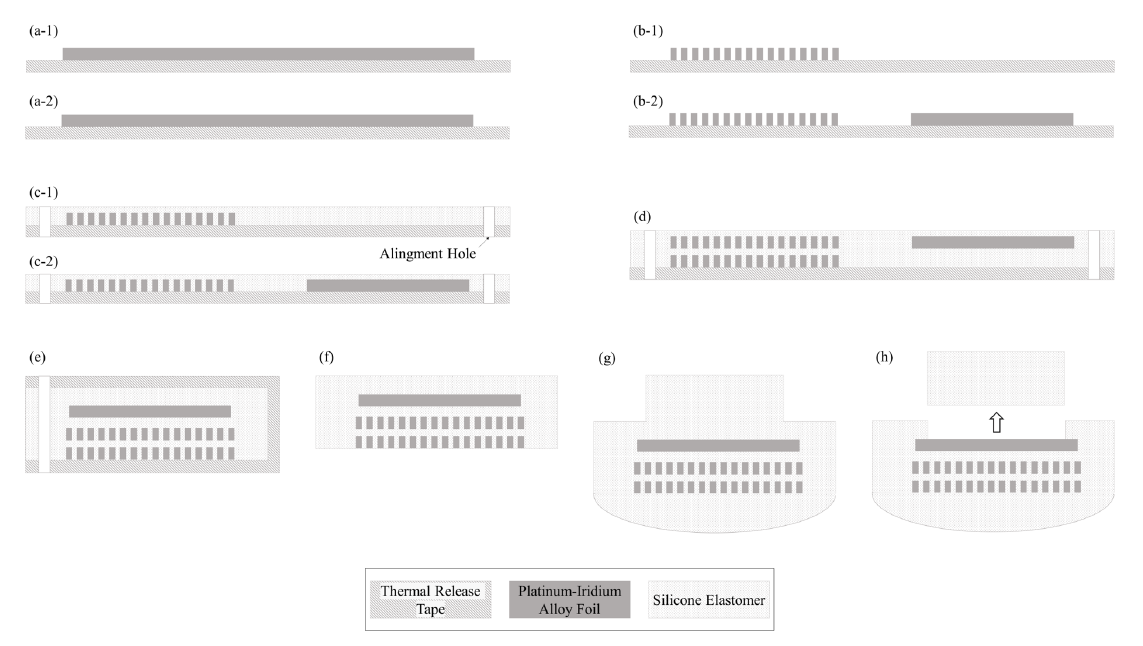
Figure 2. Fabrication Process: Cross-sectional view of electrode 32: ( a ) fixing two sheets of platinum–iridium alloy foil to each of the two thermal release tapes (Fine Technology Co., Ltd., Yangsan-si, Gyeongsangnam-do, Korea); ( b ) laser micro-structuring on platinum–iridium alloy foil; ( b-1 ) laser micro-structured 1–16-channel electrode and wire module; ( b-2 ) laser micro-structured 17–32-channel electrode and wire module; ( c ) applying thin-film silicone molding to two modules consisting of 16-channel electrode and wire arrays and forming alignment holes to the two modules; ( d ) bonding two modules of 16-channel electrode and wire arrays using silicone; ( e ) folding the 32-channel electrode and wire module to form a 3-layered arrangement: one 32-channel electrode layer and two 16-lead wire layers; ( f ) removing the sacrificial layer from the 32-channel electrode array; ( g ) forming silastic carrier behind the electrode array and applying the pillar over the electrode site; and ( h ) exposing the electrode site by removing the